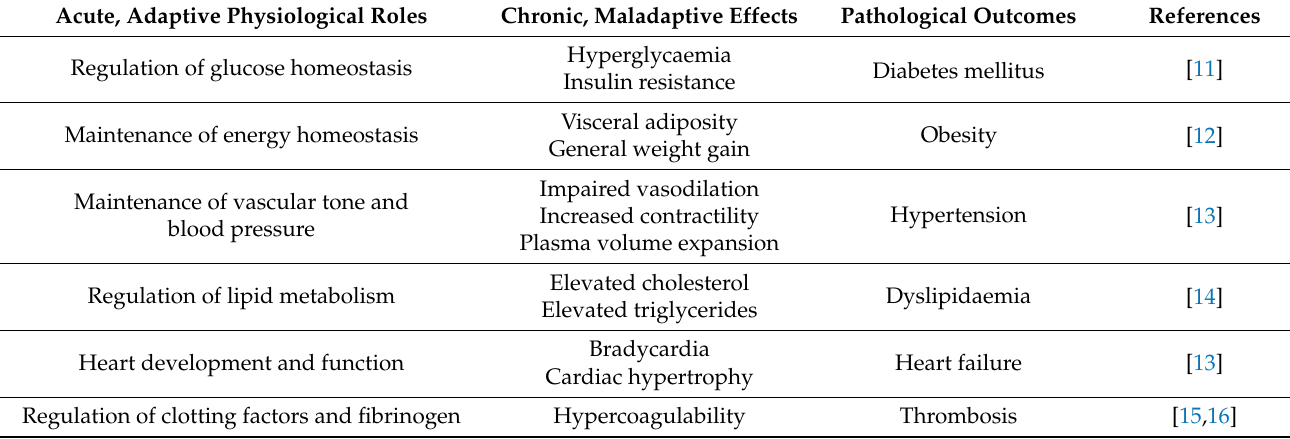
Table 1. Glucocorticoid action in cardiovascular health: when adaptive becomes